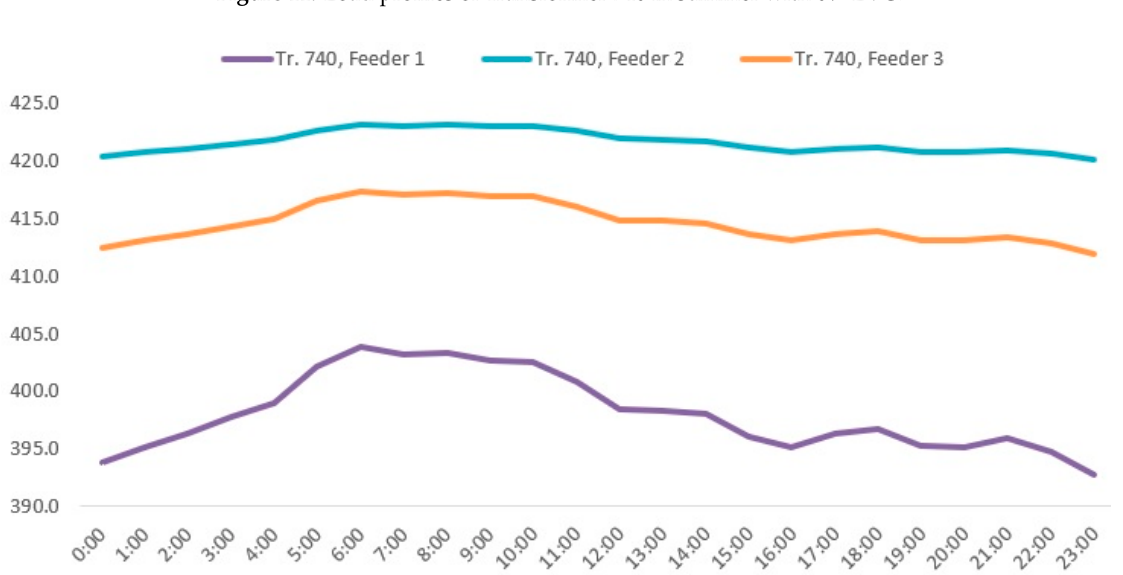
Figure 12. Voltage profile at the end of Transformer 740 in summer with 0% EVC.